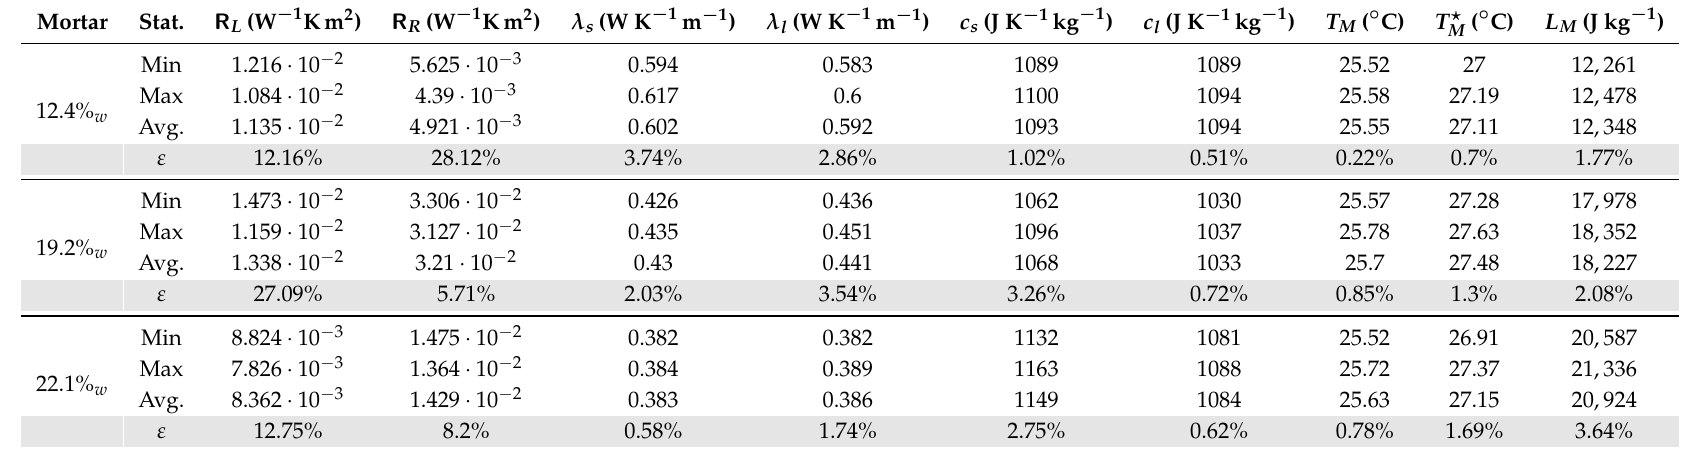
Table 3. Minimal, maximal, average values, and discrepancy between each identified parameter for each mortar (considering all ramps and various cycles).